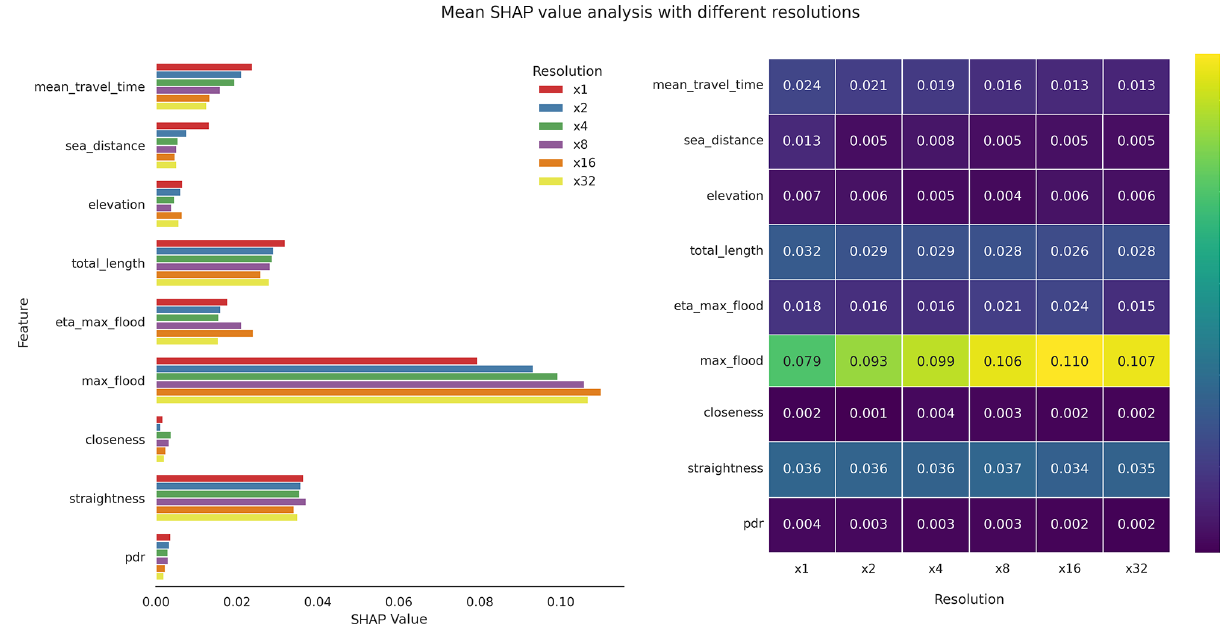
Figure 8. Mean SHAP values of the independent variables, for different spatial